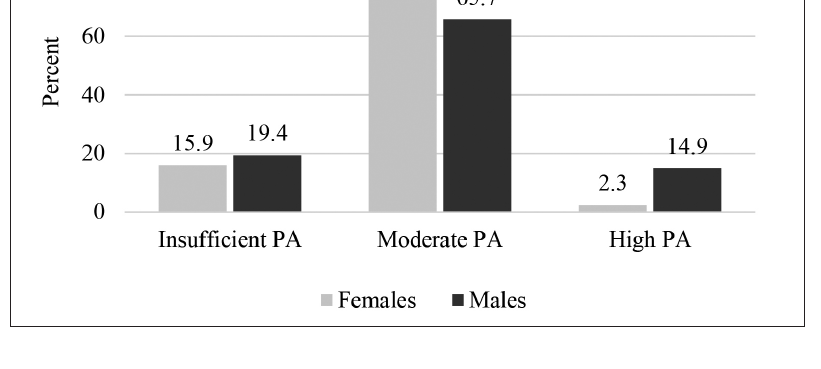
Figure 2. Breakfast consumption